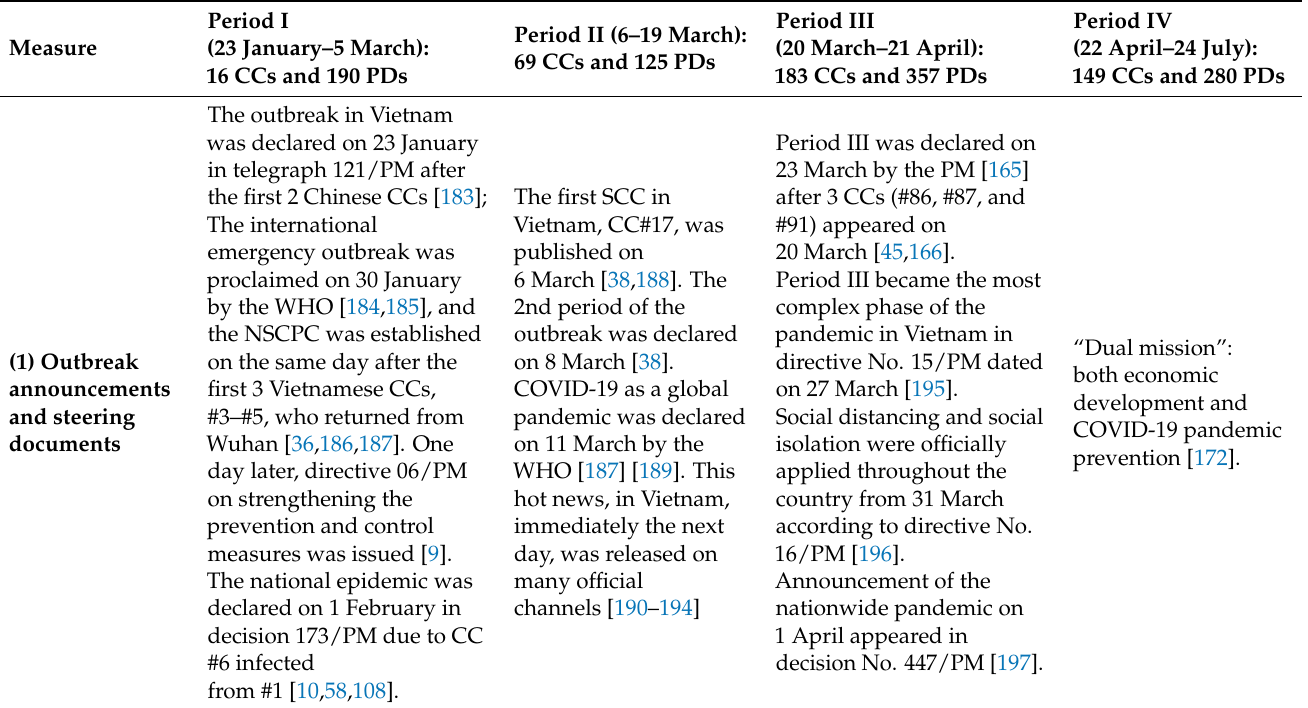
Table A1. The overall policy measures to cope with the COVID-19 pandemic in Vietnam (as of 24 July 2020).